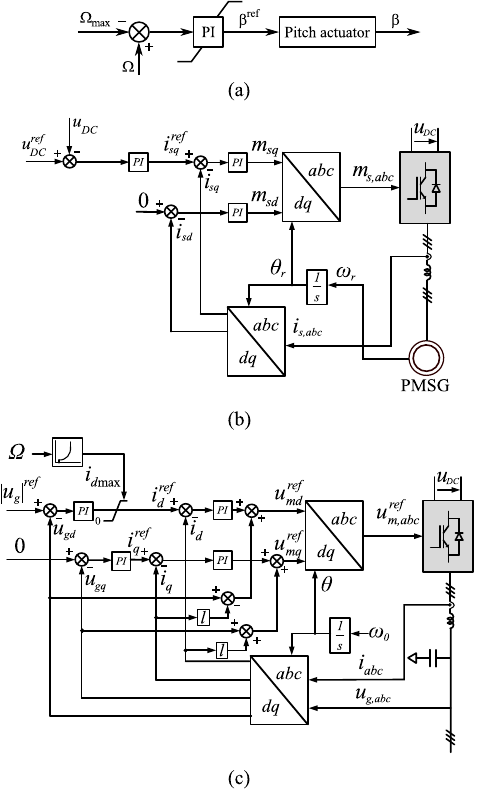
Figure 4. Control schemes of: ( a ) WT Rotational speed ( b ) GSC ( c )